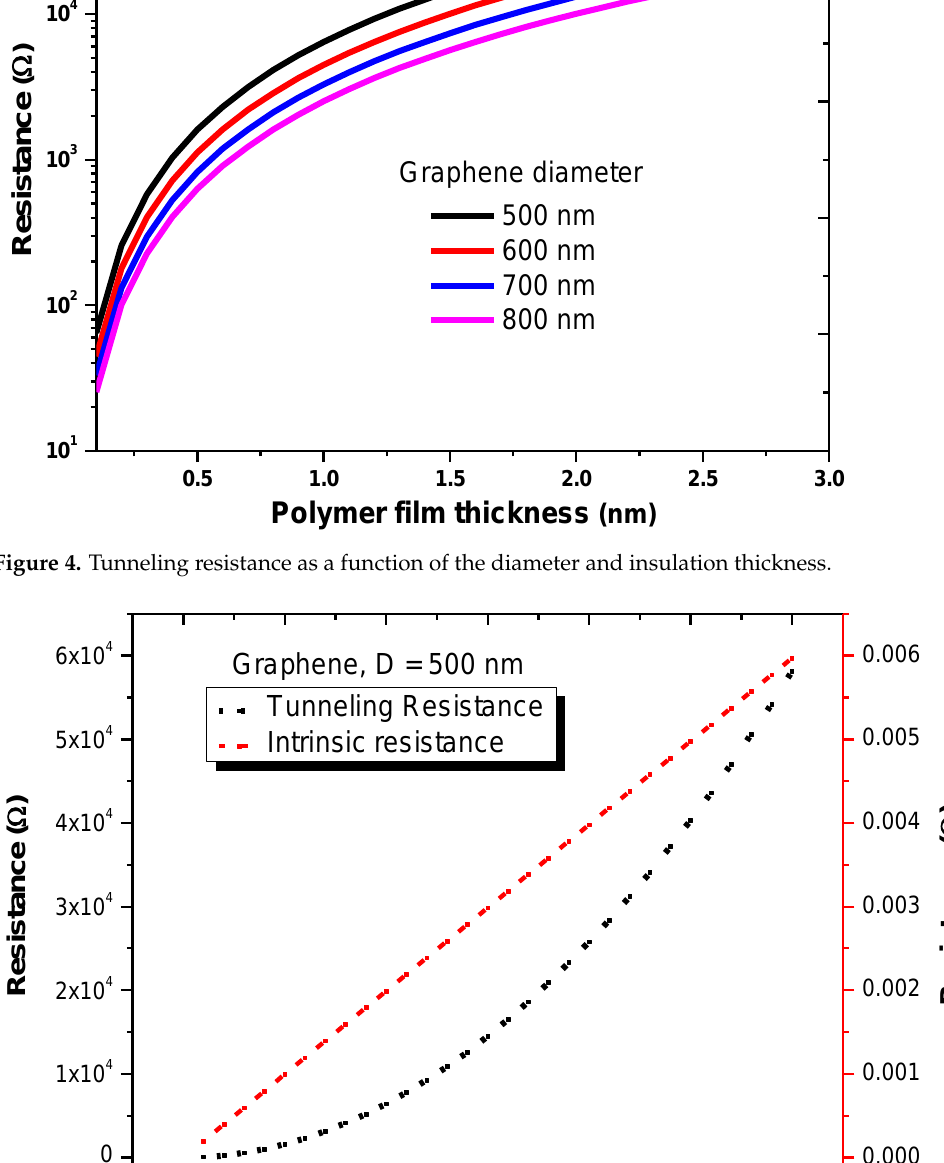
with the insulation thickness. This result agrees with the results of Gong et al. [46] and Yu et al. [24].